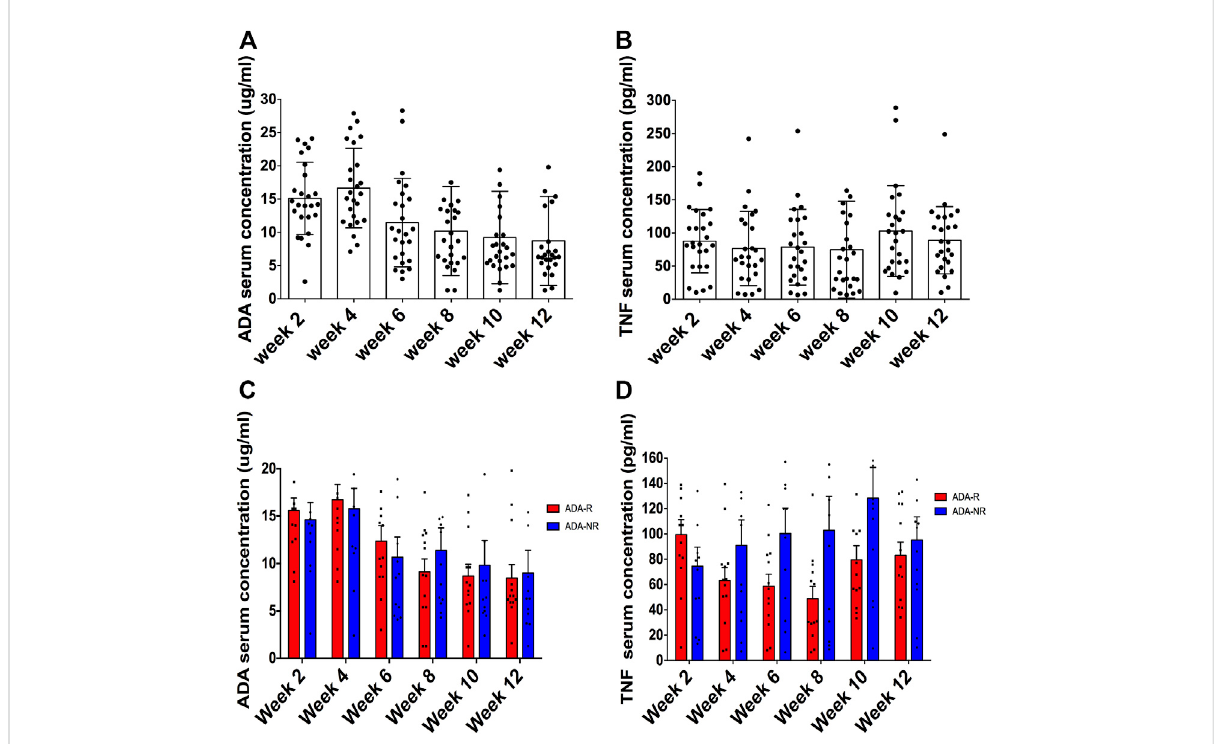
FIGURE 2 TheADAserumconcentrationisnotagoodbiomarkerforpredictingADAresponse.Of25patients,ADAserumconcentrationswerealloverthe lowest effective blood drug concentration (5 ug/ml) (A) . TNF serum concentrations presented no obvious changes along ADA treatment (B) . Furthermore, no signi fi cant differences between ADA-R and ADA-NR ADA were observed among serum concentrations (C) and serum concentrations of soluble TNF (D) . ADA-R, adalimumab responsive group; ADA-NR, adalimumab nonresponsive group.